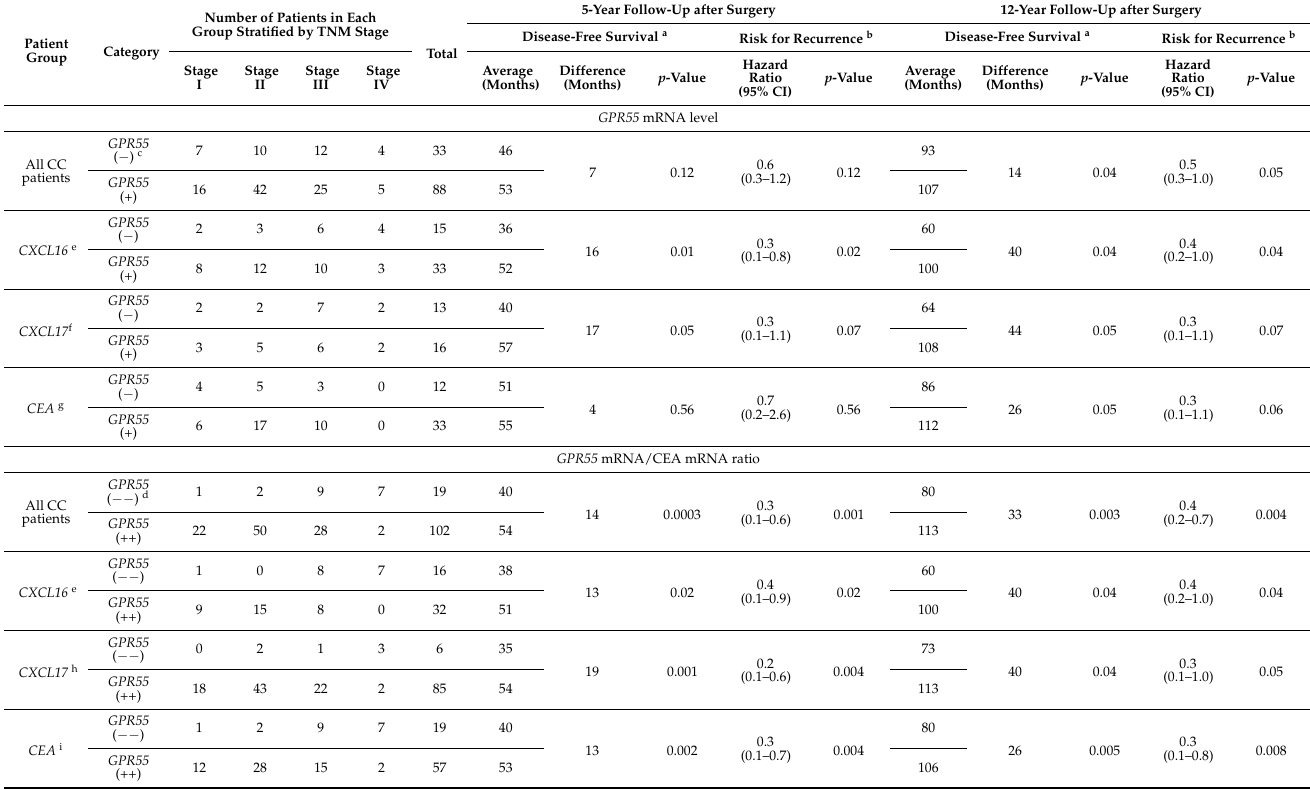
Table 2. Comparative analysis of average survival time after surgery and risk for recurrence of disease in CC patients with GPR55( − ) and GPR55(+) and those with GPR55( −− ) and GPR55(++) lymph